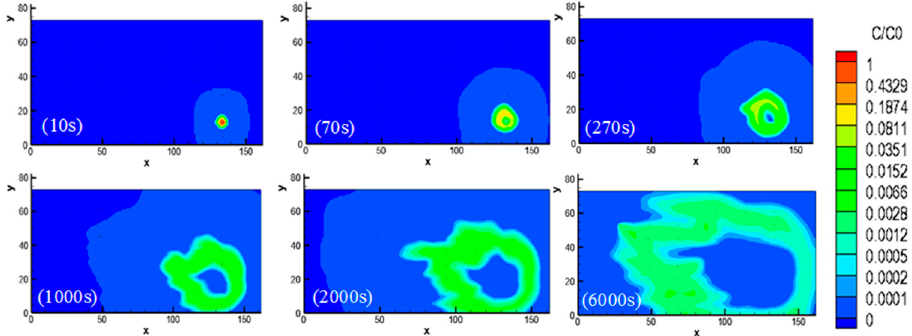
Figure 6. The positions of simulated solute transport at output time points of 10 s, 70 s, 270 s, 1000 s, 2000 s, and 6000 s under the optimal estimated K field in a group of pumping / injection tests. The units of axis are cm.